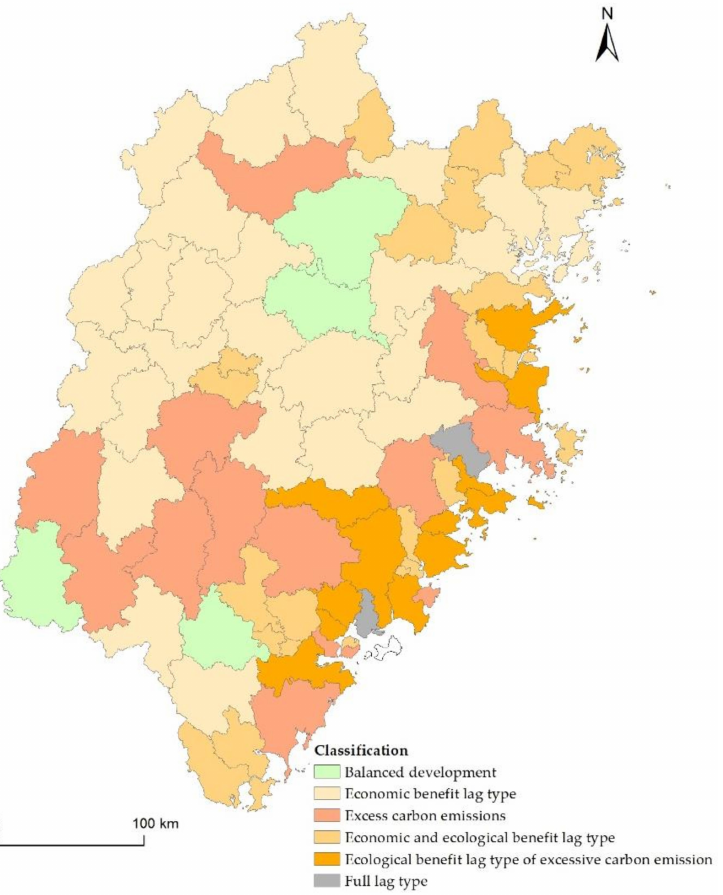
Figure 10. The distribution map of restrictive factors of land use efficiency coupling coordination relationship in Fujian Province in